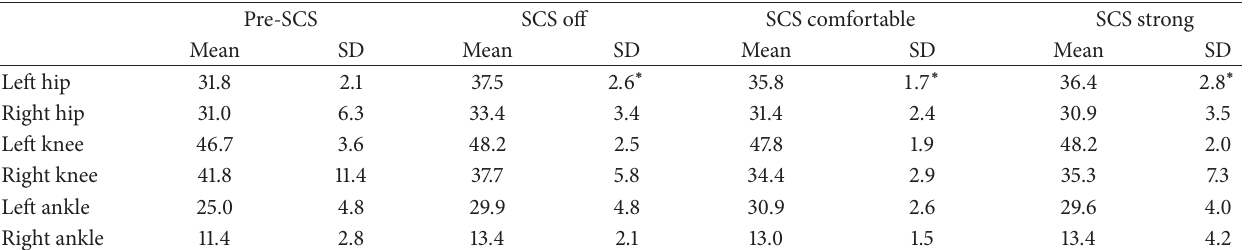
∗ 𝑝 < 0.01 ; significant difference between pre-SCS and SCS off, between pre-SCS and SCS comfortable, and between pre-SCS and SCS strong. SCS, spinal cord stimulation. SD, standard deviation.